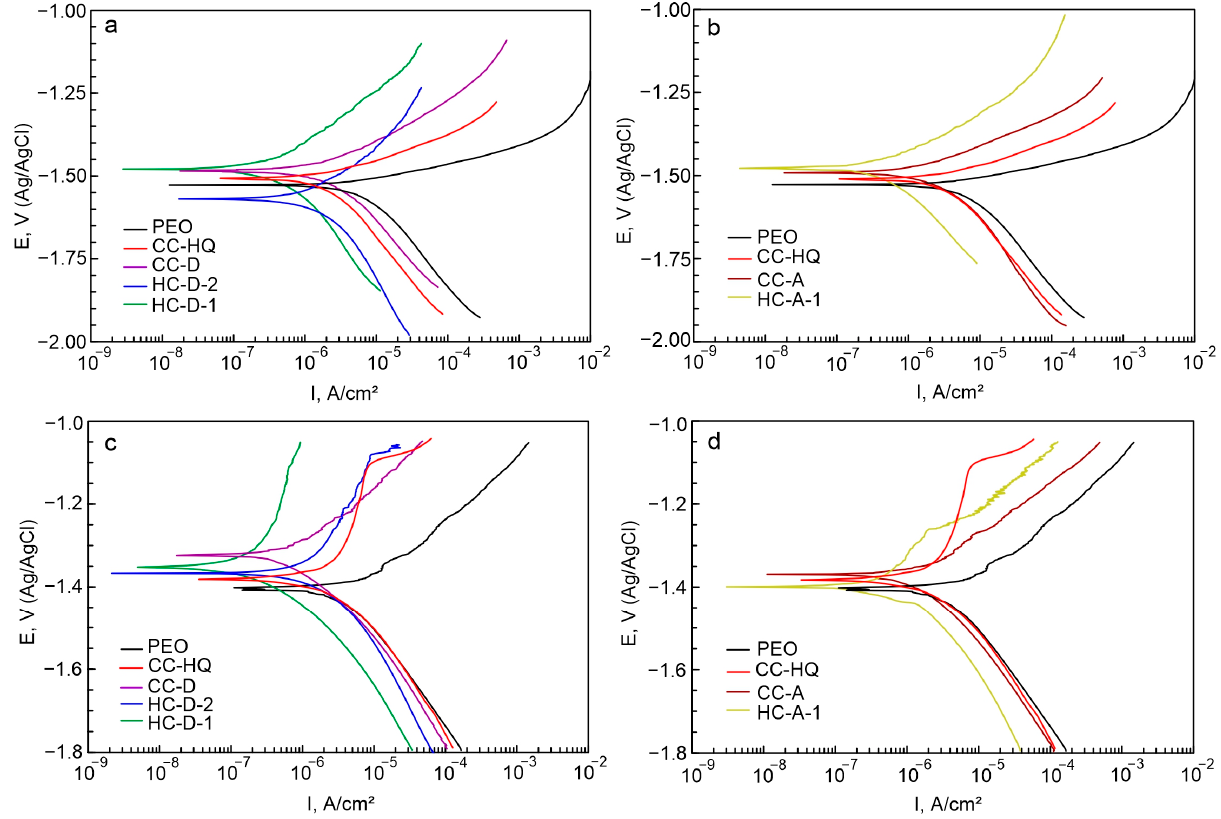
Figure 8. Polarization curves obtained after 10 min ( a , b ) and 22 h ( c , d ) exposure of samples with various coatings in 3.5% NaCl solution. Table 1. Electrochemical parameters * obtained during the analysis of polarization curves and impedance spectra after the exposure of the samples to 3.5 wt.% NaCl solution.